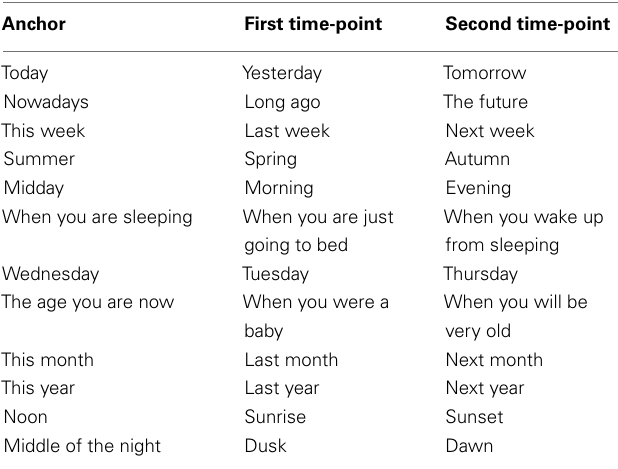
Table 5 |Translation targets for the named temporal sequences in two